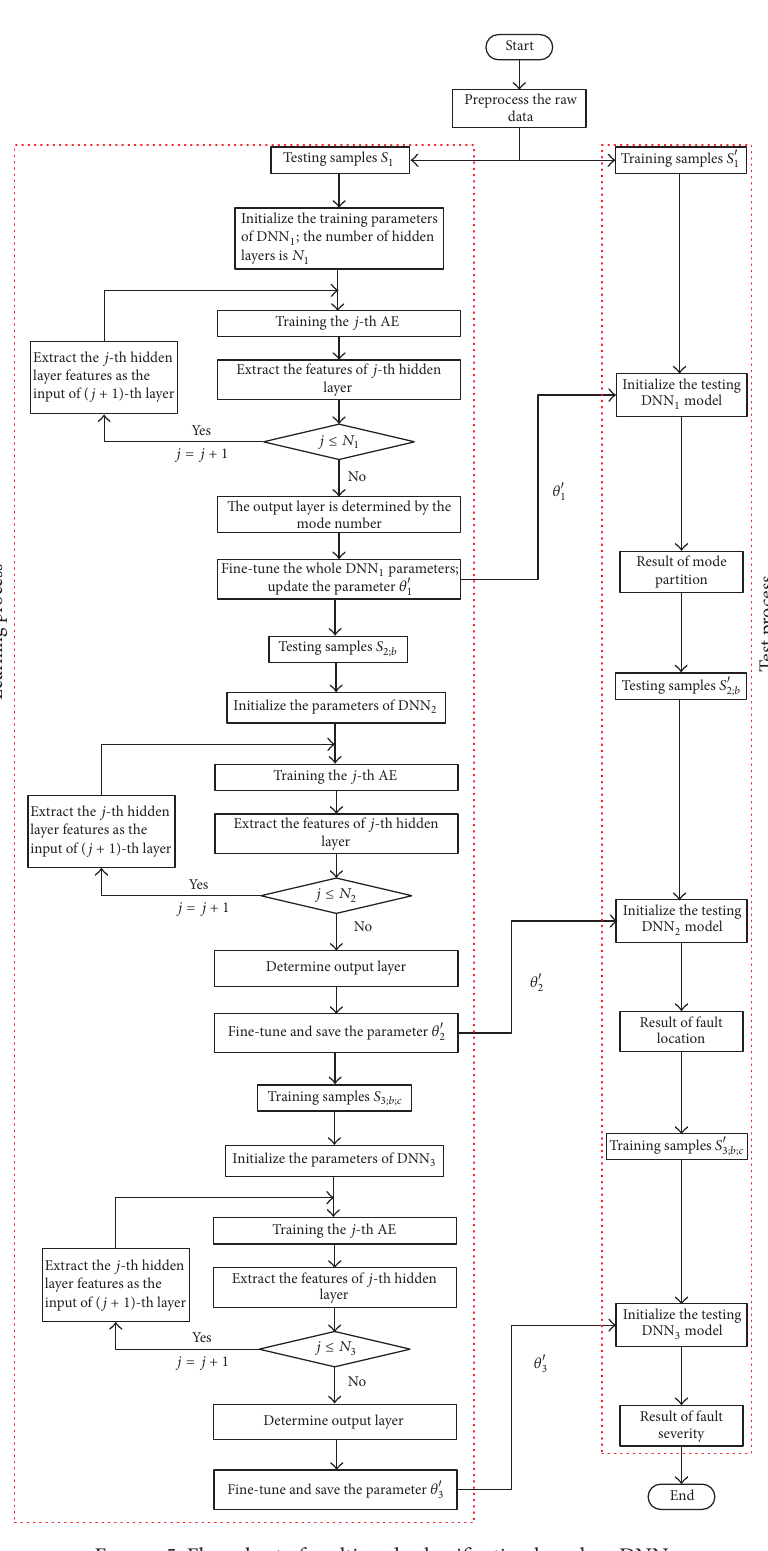
Figure 5: Flow chart of multimode classification based on